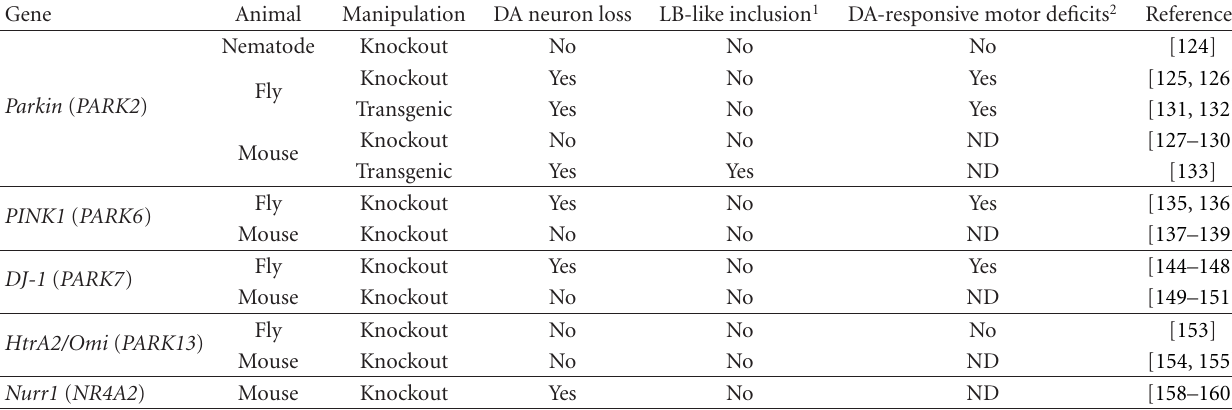
Table 3: Autosomal-recessive PD models and other causative genes of